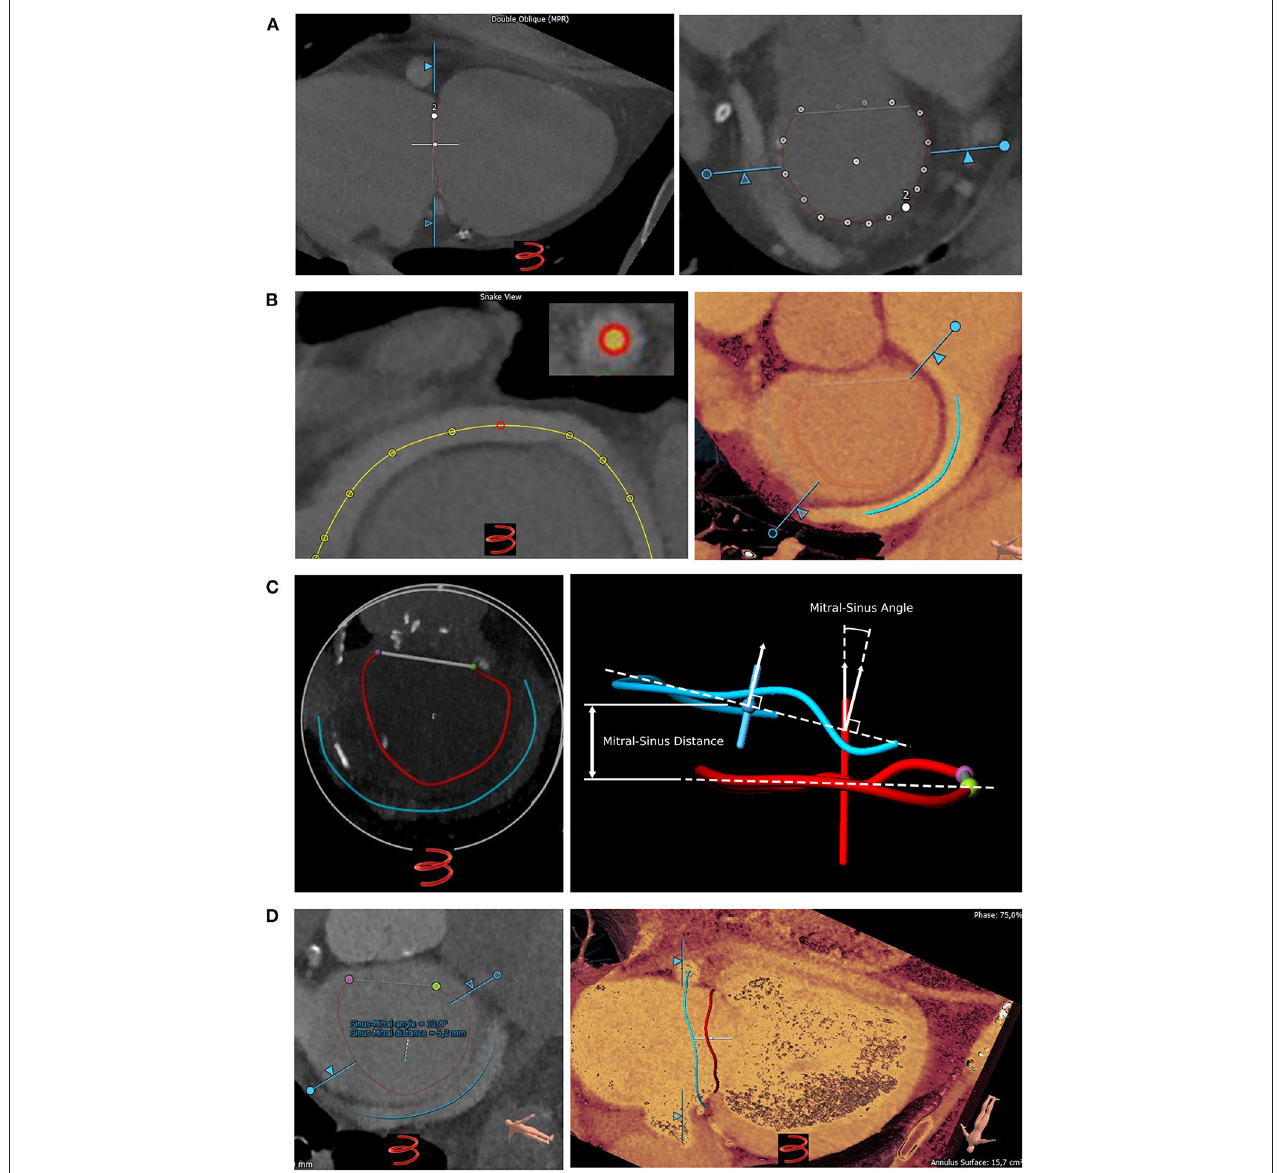
FIGURE 1 | Assessment of coronary sinus to mitral valve annulus topography using a Multislice CT (MSCT) analysis prototype software. (A) Left: Semiautomatic tracking of the mitral valve annulus (MVA). Right: White dots indicate the tracked MVA. (B) Left: Tracking the coronary sinus (CS; yellow line). Right: MSCT showing the CS (blue line) entering the right atrium. Red line: MVA. (C) Left: 3D-model of MVA (red line, D-shape) and CS (blue line) showing their anatomical relation. Right: Centroid (red dot for MVA and blue dot for CS) and axis (red line for MVA and blue line for CS) of the MVA and CS. The normal vector is visualized by the horizontal dotted line. The sinus-mitral angle is located between the axes/normal vectors of the MVA and the CS. (D) Left: After MVA and CS reconstruction the prototype software calculates both distance and angulation of CS to MVA planes automatically. Right: Three-dimensional visualization allows evaluation of CS to MVA